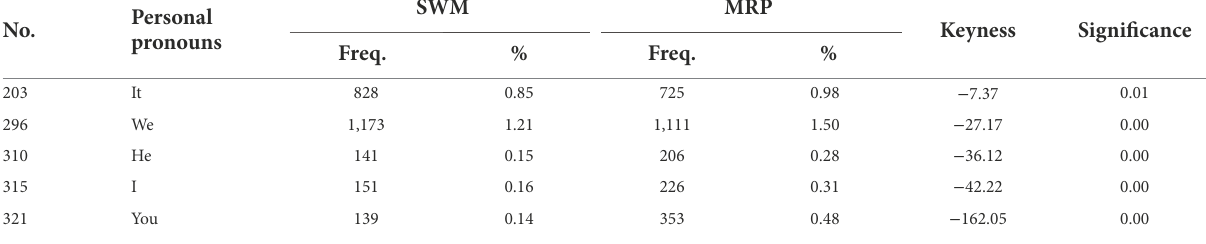
TABLE 4 Key personal pronouns in SWM (in comparison with WCH).